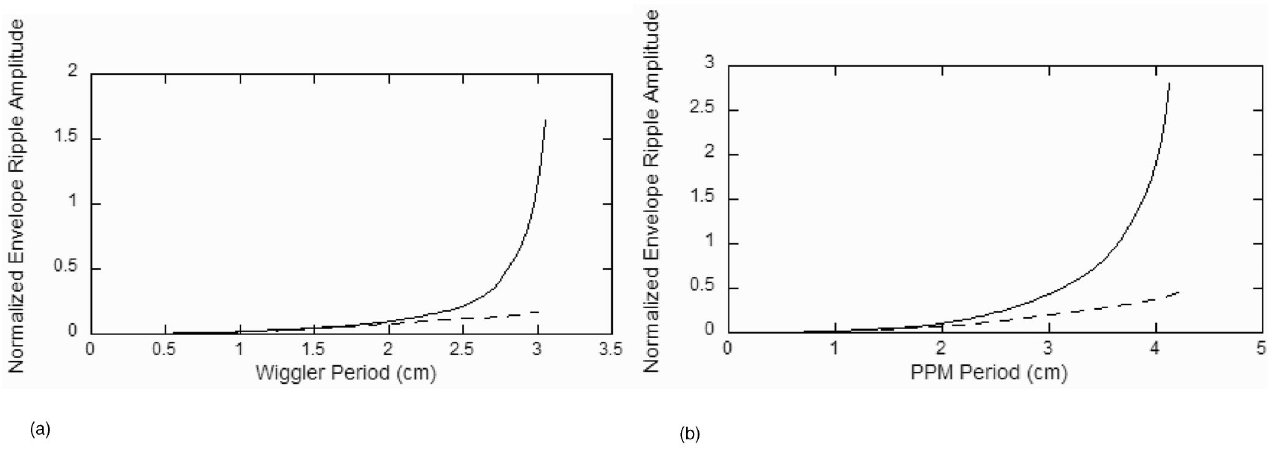
FIG. 8. Envelope ripple amplitude versus focusing period, solid line emittance-dominated beam, dashed space-charge dominated beam. (a) Wiggler focusing. (b) PPM